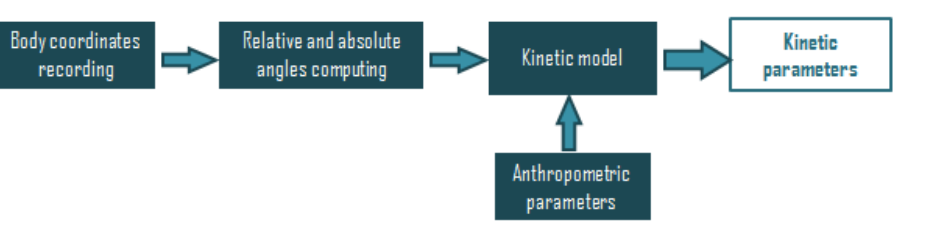
Fig. 2. The scheme for new parameter computation.